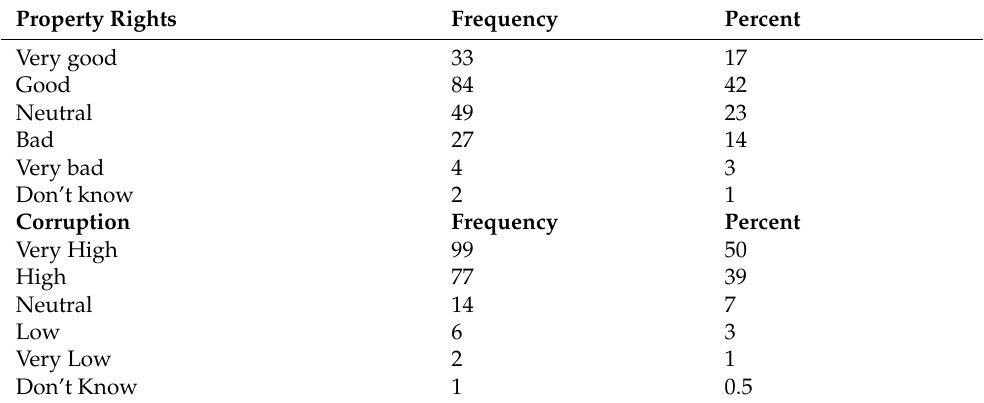
Table 1. Forest property rights and corruption in